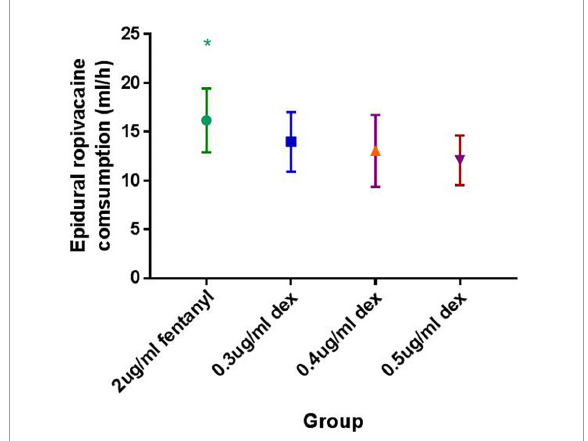
FIGURE2 Mean hourly ropivacaine consumption between groups. * P < 0.0001 for one way